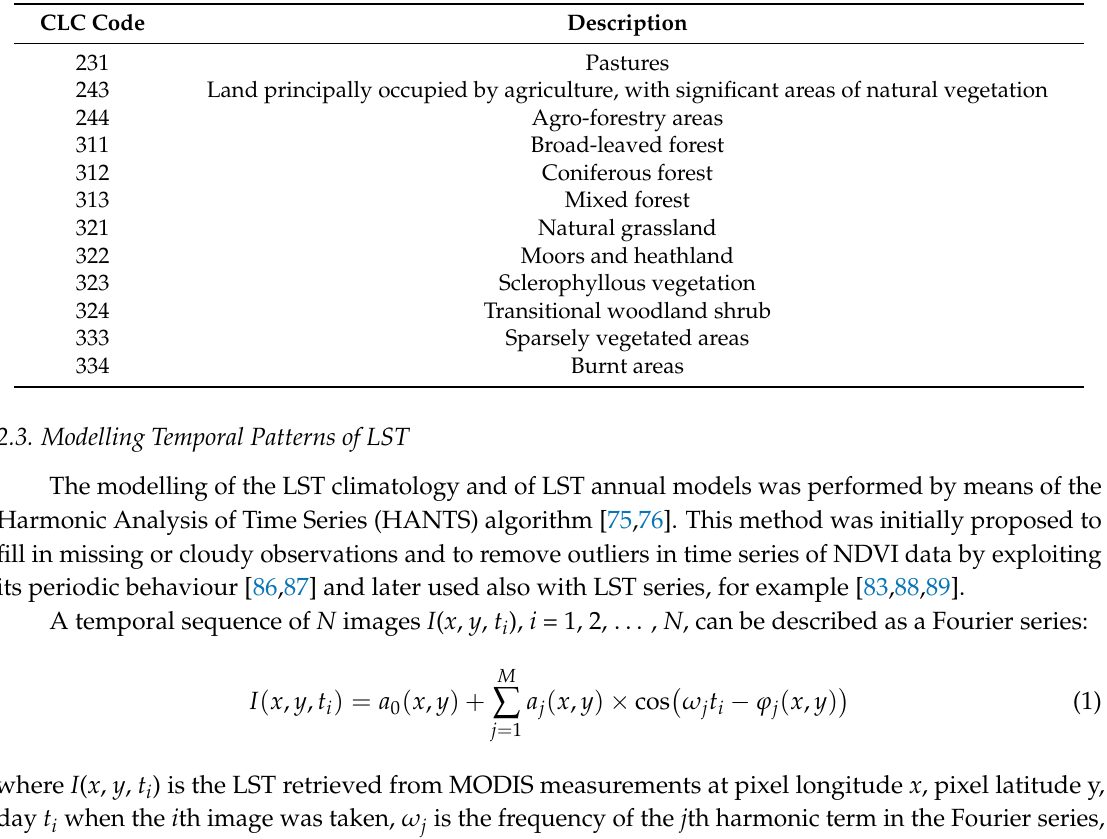
Table 1. CORINE Land Cover (CLC) classes used to select fires used in subsequent